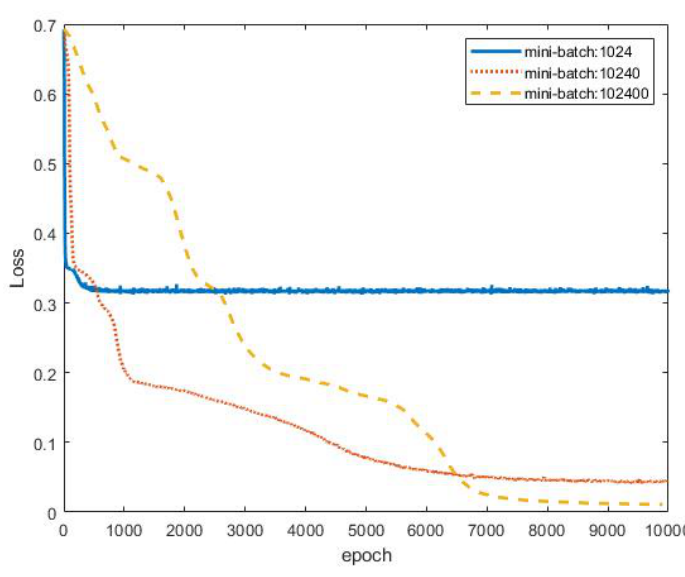
Figure 15. Loss function for different mini-batch sizes in the MIMO-NOMA-DL